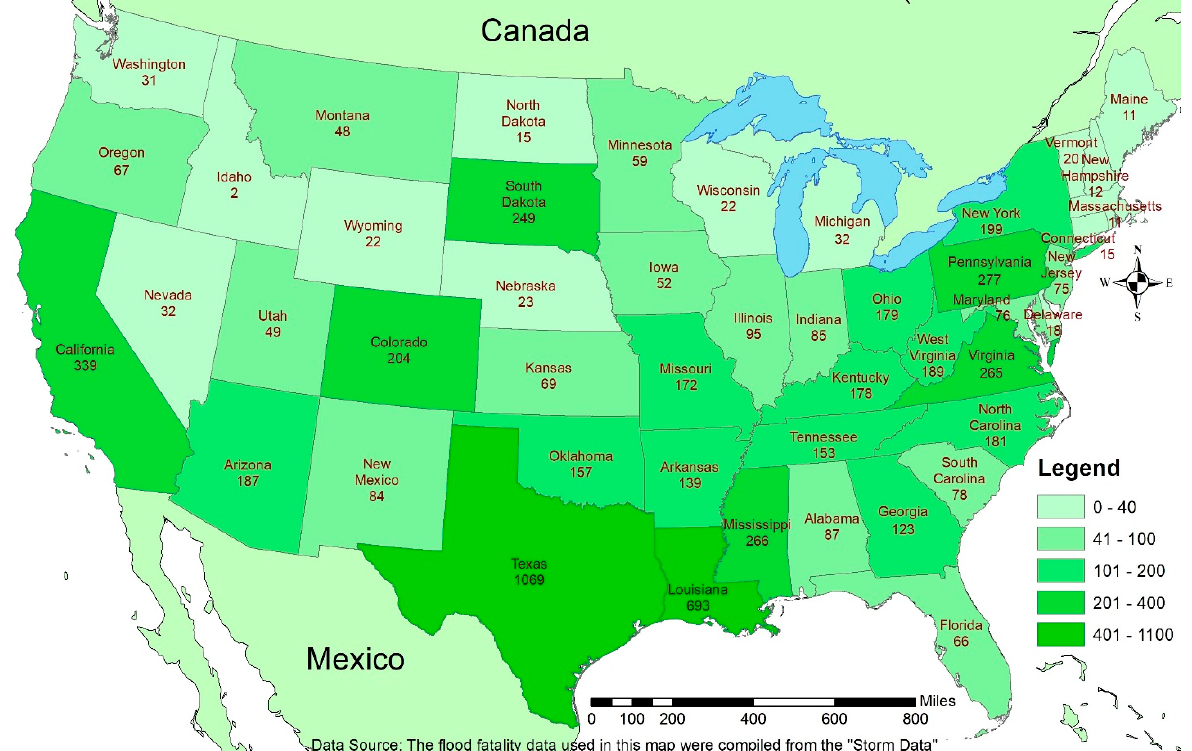
Figure 1. Flood fatalities in the contiguous US (1959–2019) by state. The NWS has 122 weather forecast offices across the US. Each weather forecast office (WFO or NWSFO) has a geographic area of responsibility (county warning area) for issuing local public, marine, aviation, fire, and hydrology forecasts as well as severe weather warnings and coordinates with local agencies in flood mitigation efforts. As risks and vulnerability are not defined by state lines, we also show the distribution of flood fatalities at the NWS WFO service area level in Figure 2. Some of the WFOs in the north have not reported any fatalities in the study periods while others have witnessed hundreds of fatalities. In general, the information is similar to that of Figure 1 but shows some contrasts within some of the states. For example, some WFOs on the Atlantic and Gulf coasts reported relatively very low numbers of fatalities. The New Orleans/Baton Rouge WFO (LIX), where Hurricane Katrina occurred, had the highest number of flood fatalities (861) in the nation. The second and third WFOs are the Austin/San Antonio WFO (EWX) and the Fort Worth/Dallas WFO (FWD) with 381 and 263 fatalities, respectively, both located in the Flash Flood Alley area in Texas. The Rapid City WFO (UNR) reported 241 flood fatalities of which 237 were due to a dam failure in June 1972.